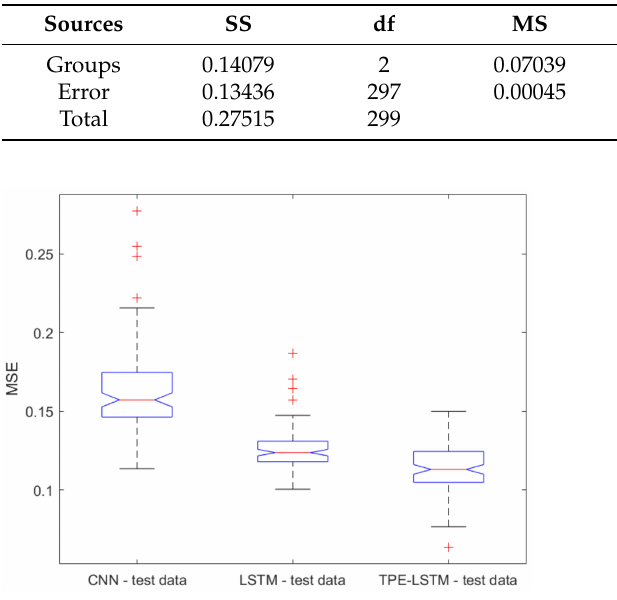
Figure 6. MSE: test data, all runs. CNN, LSTM, and